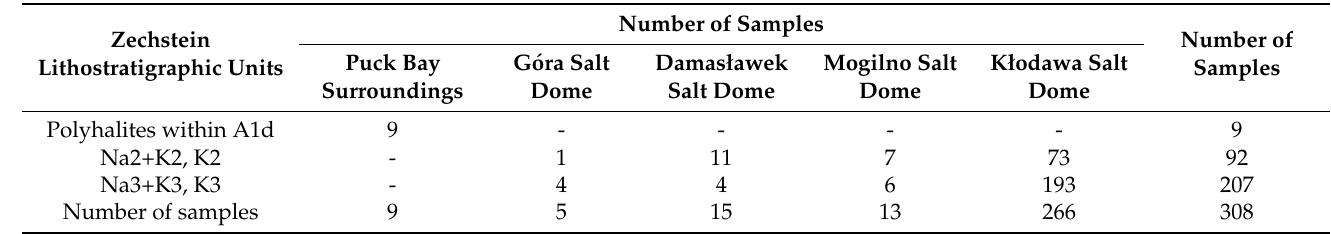
Table 2. Location and number of analysed (trace elements content) samples from Zechstein potash- bearing deposits in